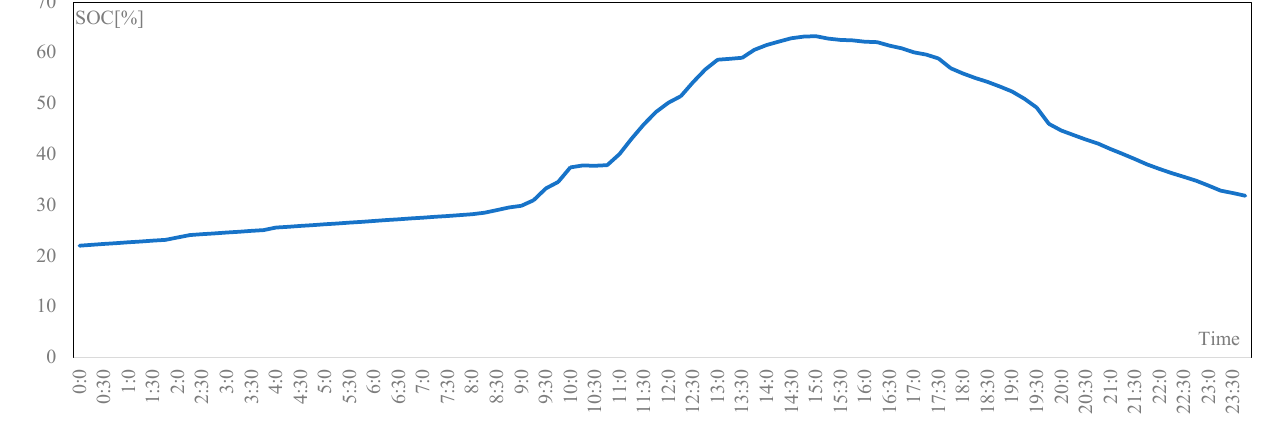
Figure 19. ESS SOC with flexibility service.